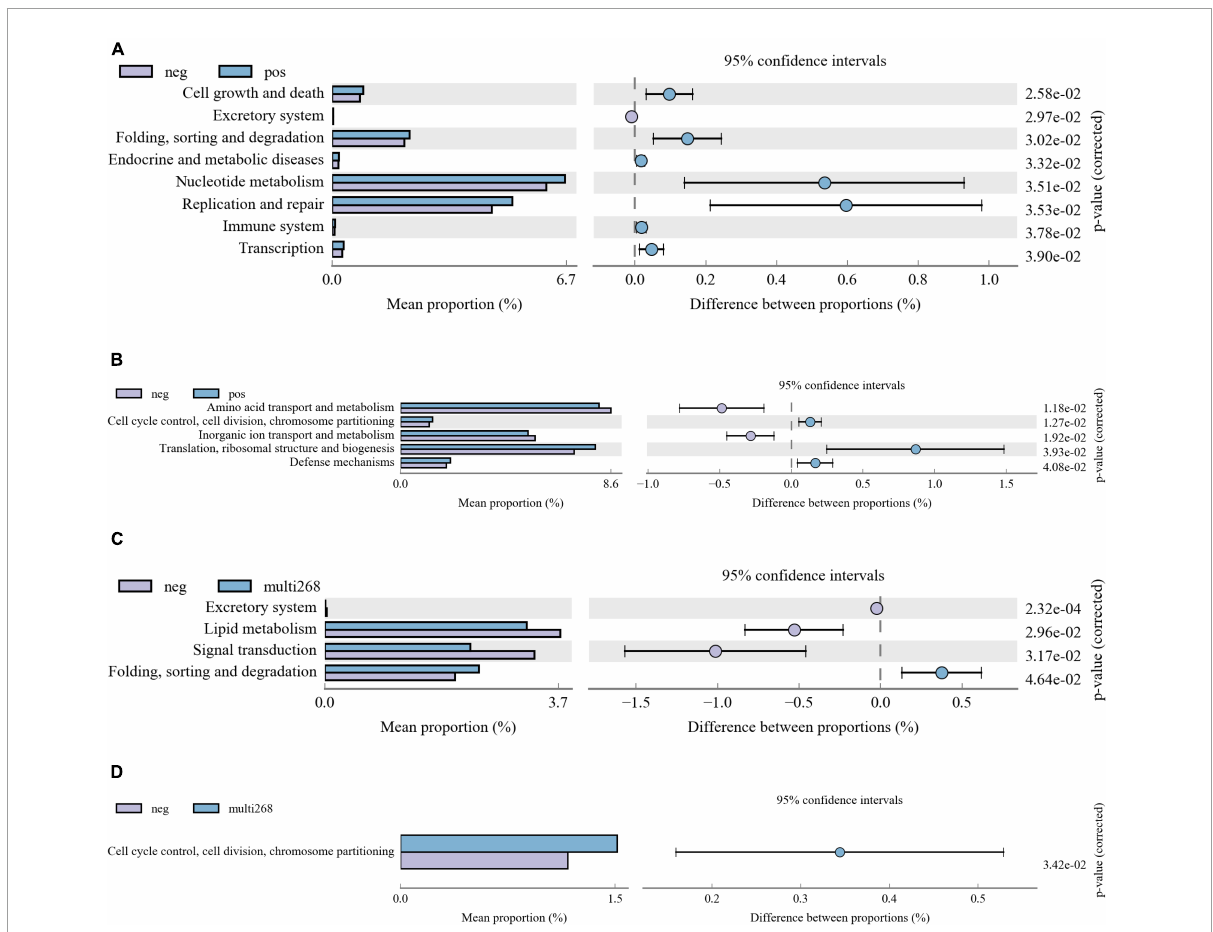
FIGURE3 Microbiota KEGG and COG function difference diagrams. The picture shows the difference analysis diagram of the KEGG (and COG) metabolic pathway under the second level (also can be analysed for the third or first level): the different colours in the picture represent different groups. The figure shows the abundance ratio of different functions in the two sets of sample groups, the middle shows the difference ratio of the function abundance within the 95% confidence interval, and the rightmost value is the p -value. (A) KEGG pathway difference between HPV-positive and HPV-negative patient groups, (B) COG pathway difference between HPV-positive and HPV-negative patient groups. (C) KEGG pathway difference between multi-268 HPV infections and HPV-negative patient groups, (D) COG pathway difference between multi-268 HPV infections and HPV-negative patient groups. KEGG, Kyoto Encyclopedia of Genes and Genomes; COG, Clusters of Orthologous